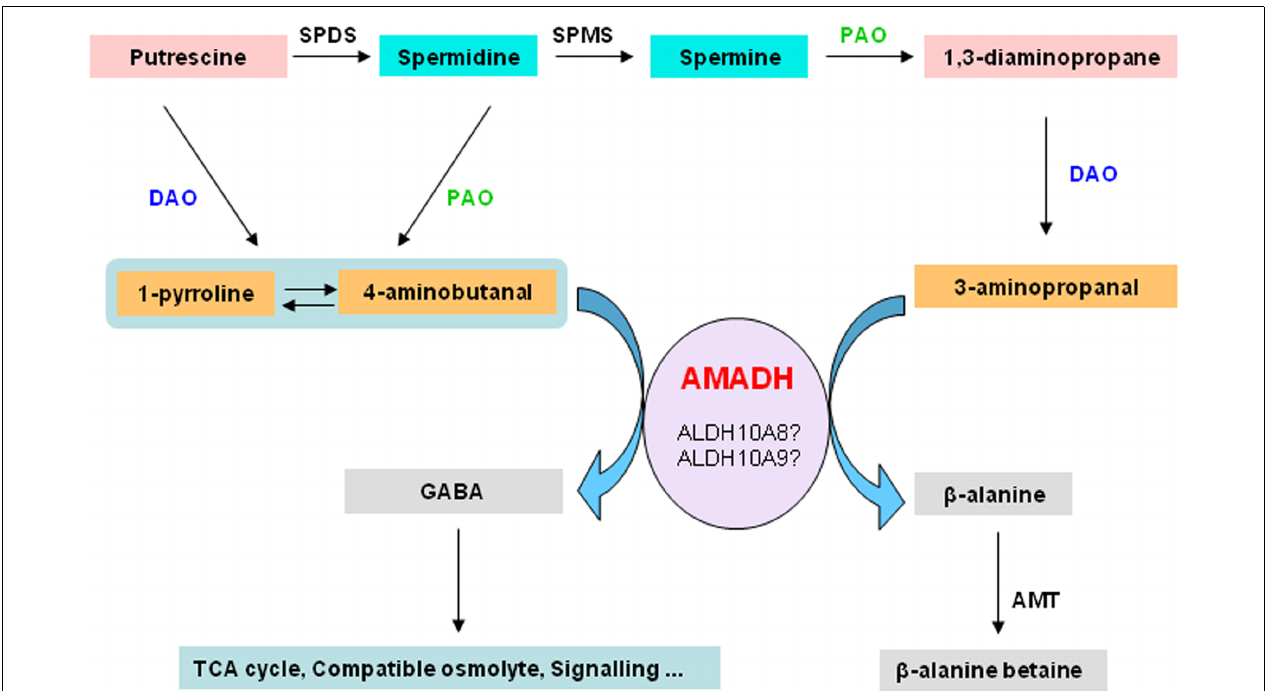
a signal compound. It can also be funneled to theTCA cycle or accumulated as compatible osmolyte. Beta-alanine–betaine accumulates in certain members of the Plumbaginaceae as compatible osmolyte. SPDS, spermidine synthase; AMADH, aminoaldehyde dehydrogenase; SPMS, spermine synthase; PAO, polyamine oxidase; DAO, diamine oxidase; GABA, γ -aminobutyric acid;TCA, tricarboxylic acid; AMT, β -alanine methyl